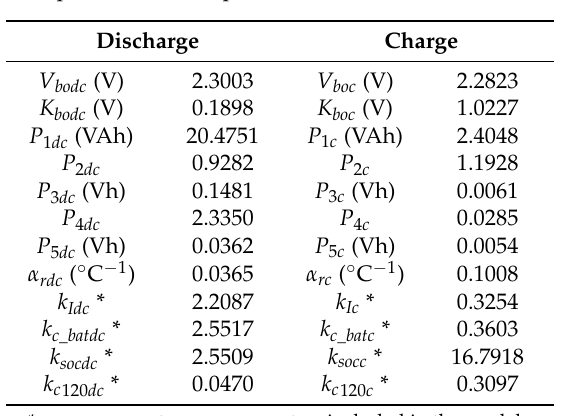
Table 4. Parameters from particle swarm optimization (PSO) + P identification in daily data